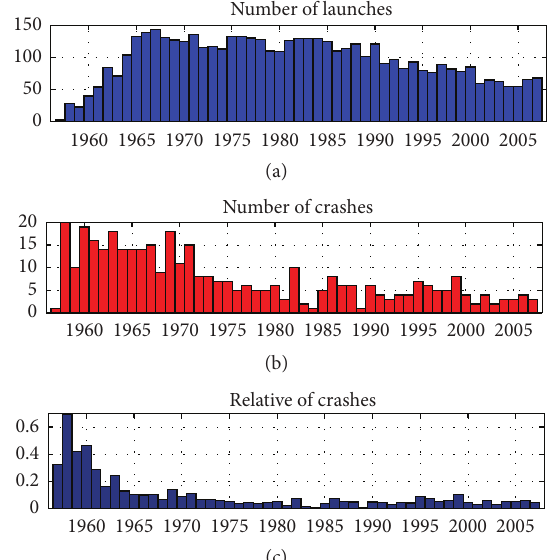
Figure 3: Yearly distributions of the number of launches, launch failures, and relative number of crashes for all world-wide launches from 1957 till 2007. Relative number of crashes is the number of crashes per year normalized by the number of total launches that year.